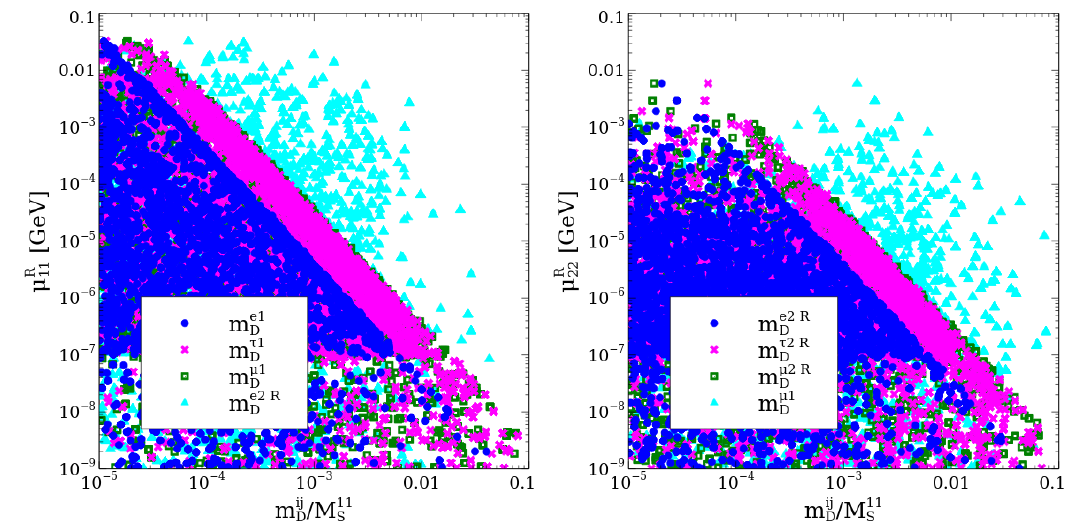
Figure 3 . Allowed parameter spaces after imposing the NOD constraints and the LFV bounds are shown in the m ij – µ R ( ij = { e 1 , τ 1 , µ 1 , e 2 R } ) plane in the left panel and in the m ij /M 11 11 S D ( ij = { e 2 R, τ 2 R, µ 2 R, µ 1 } ) plane in the right µ R 22